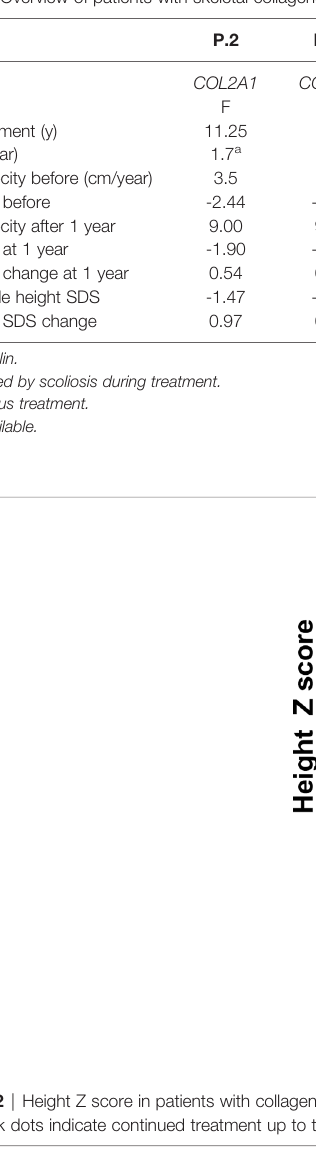
TABLE 3 | Overview of patients with skeletal collagenopathies with rhGH treatment.